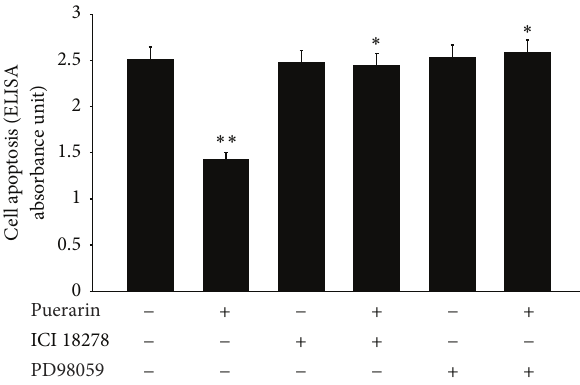
0.511.522.53 Figure 5: ERK signaling pathway and estrogen receptor mediated the antiapoptotic effects of puerarin in hOBs. Cells were incubated with PD98059 (10 𝜇 M) and/or ICI 182780 (10 𝜇 M) for 3 h prior to treatment with 10 −8 M puerarin for 48h. The bars represented the mean ± SD ( 𝑛 = 6 ). ∗ 𝑃 < 0.05 , as compared with the puerarin- treated cells; ∗∗ 𝑃 < 0.05 , as compared with the serum-free treated